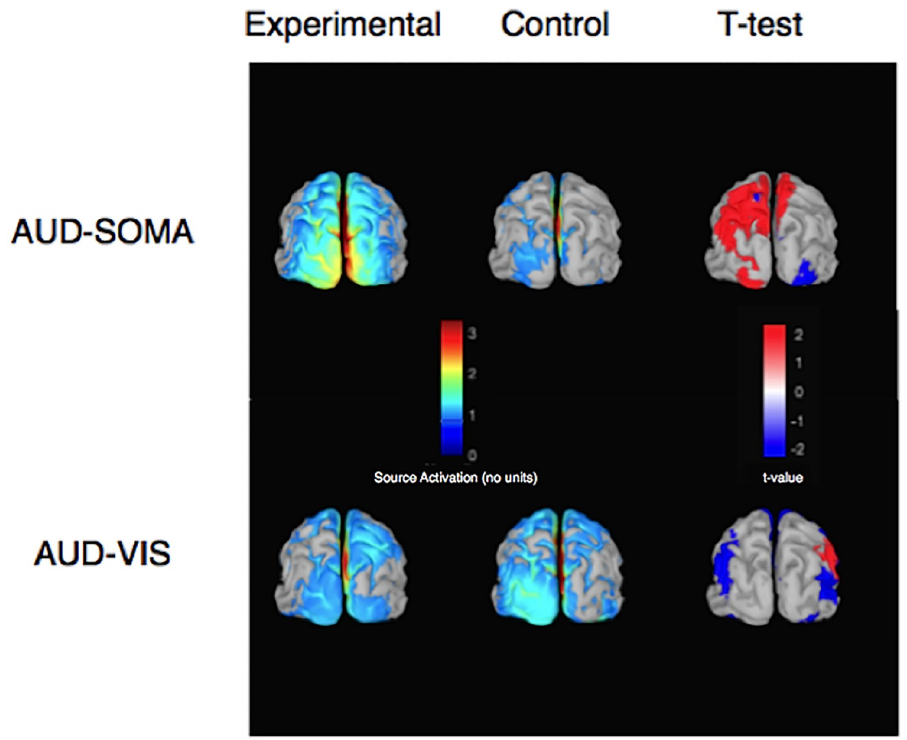
Fig 6. Grand average source activity for each condition between 100 ms and 150 ms after stimulus onset (i.e., source activity corresponding to the P100 –N150 component of the visual evoked potential). Source activity (color maps reveal activation levels) was localized in parietal and occipital areas in both experimental and control conditions. Statistical contrasts (paired-samples t-tests, alpha set to 0.05, t-value map indicates direction of effects) revealed significantly more activity in the left parietal and parieto-occipital regions (as indicated by the shade of red) for the AUD-SOMA experimental condition compared to the AUD-SOMA control condition.